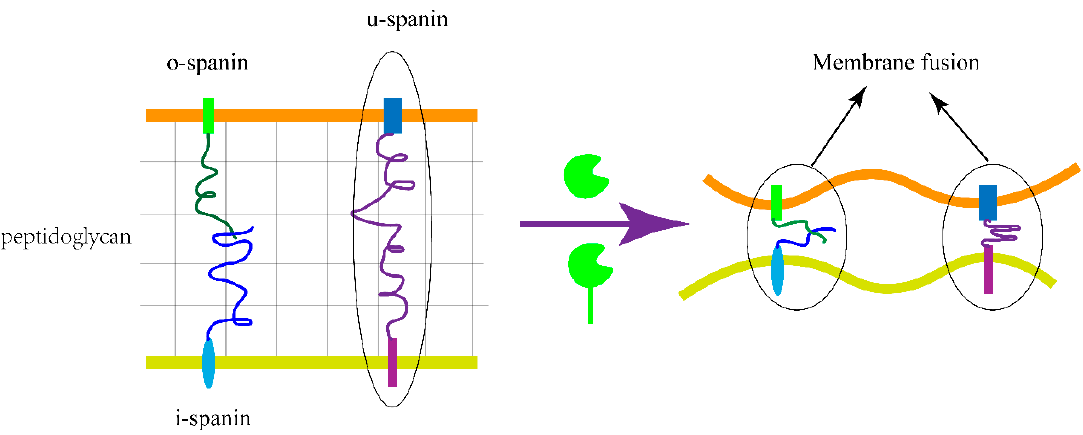
Figure 3. Two spanin systems disrupt the outer membrane by membrane fusion. The three spanins accumulate in the envelope and are trapped within the lacuna of the peptidoglycan layer. When endolysin or SAR endolysin removes the peptidoglycan layer, the spanins bring the two membranes together through conformational